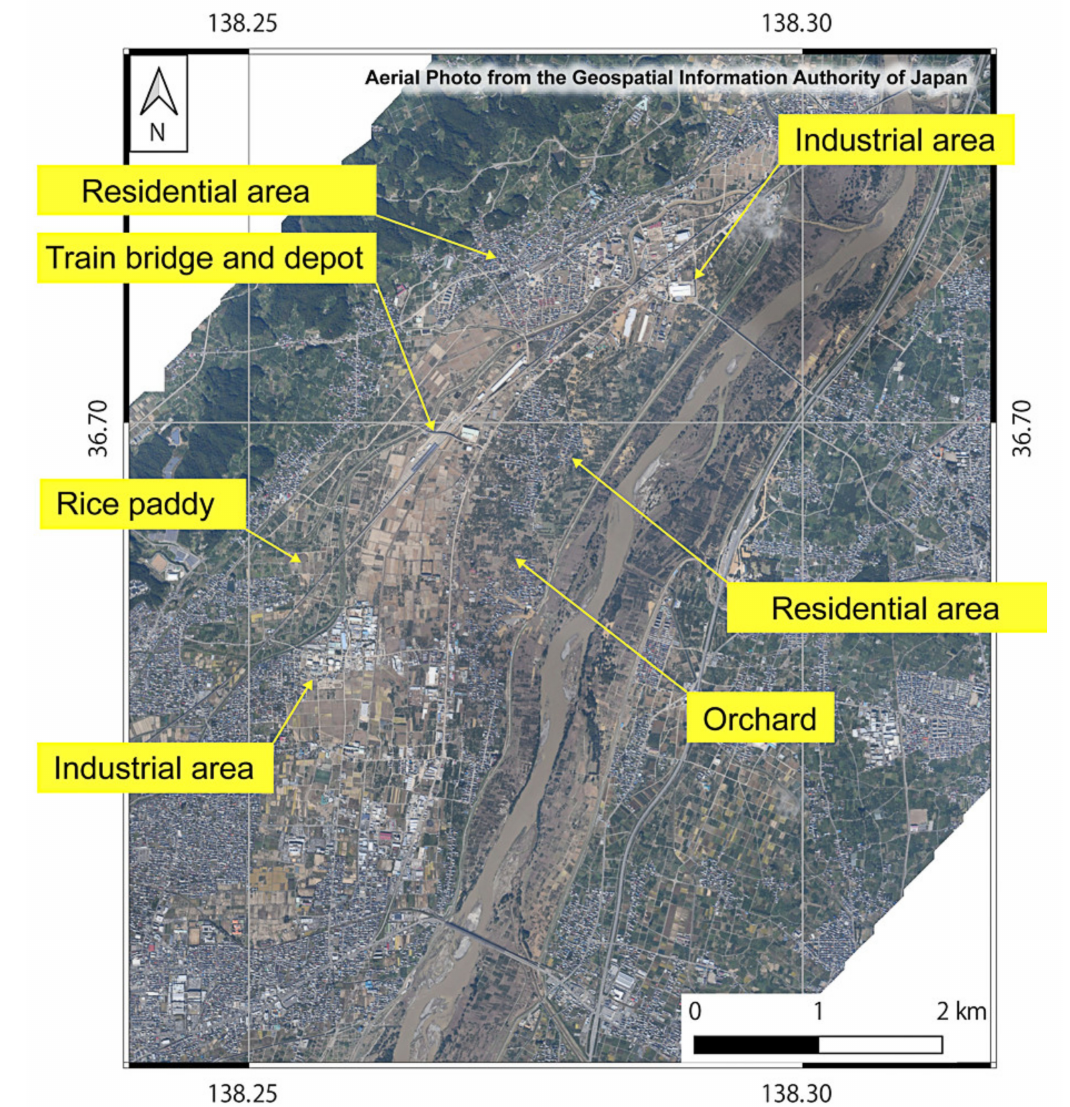
Figure 3. Optical image of the close-up